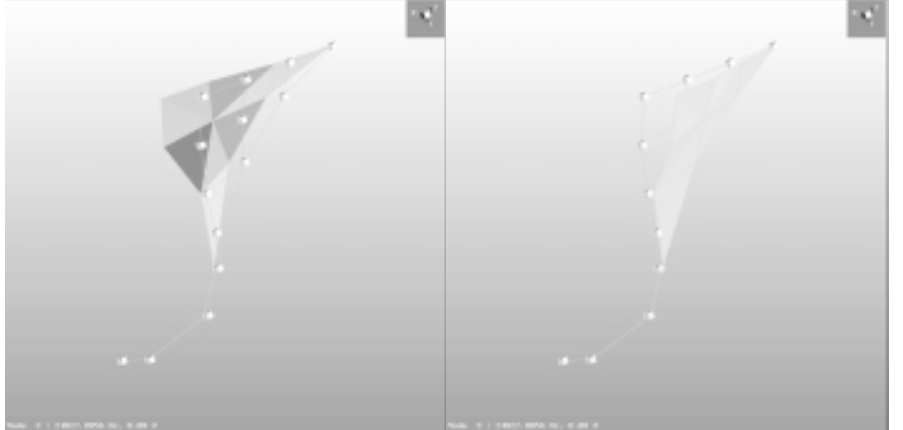
Fig. 16. Blade’s mode shape at 24050 Hz.